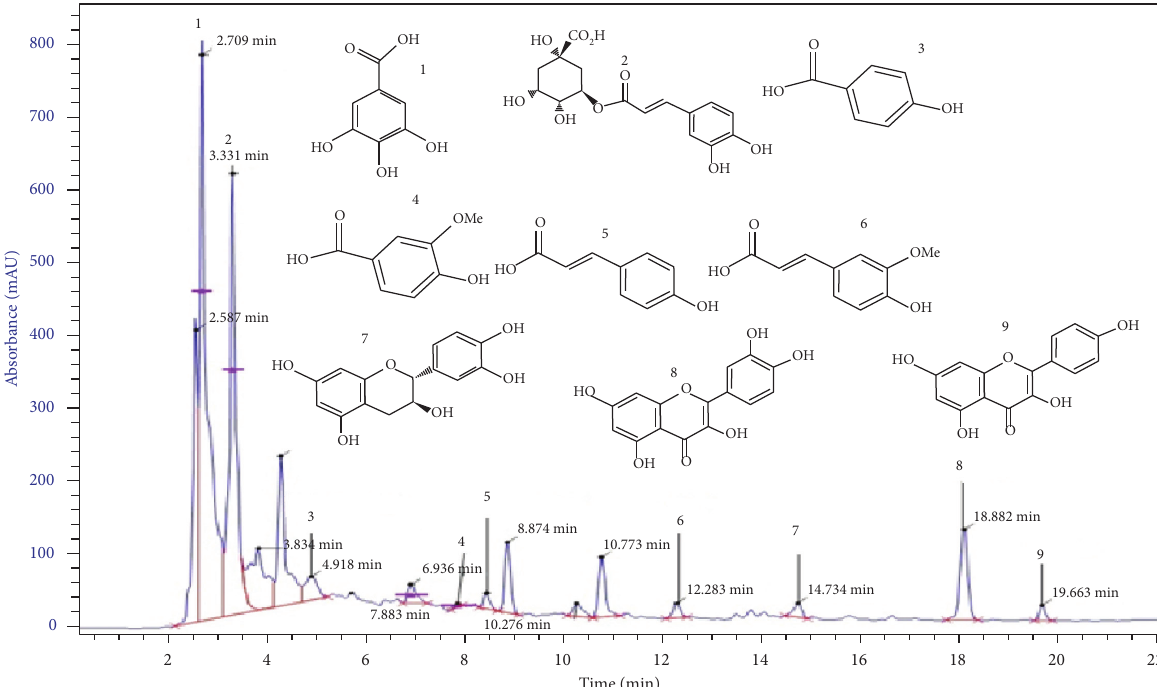
Figure 3: Typical chromatogram of phenolic acid and flavonoids of normal seeded tomatoes. (1) Gallic acid, (2) chlorogenic acid, (3) p- hydroxy benzoic acid, (4) vanillic acid, (5) p-coumaric acid, (6) ferulic acid, (7) catechin, (8) quercetin, and (9) kaempferol.